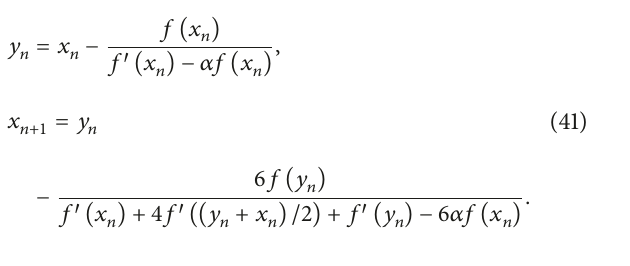
Algorithm 13. The iterative scheme which will compute the approximate root 𝑥 𝑛+1 for initial guess 𝑥 0 is given as